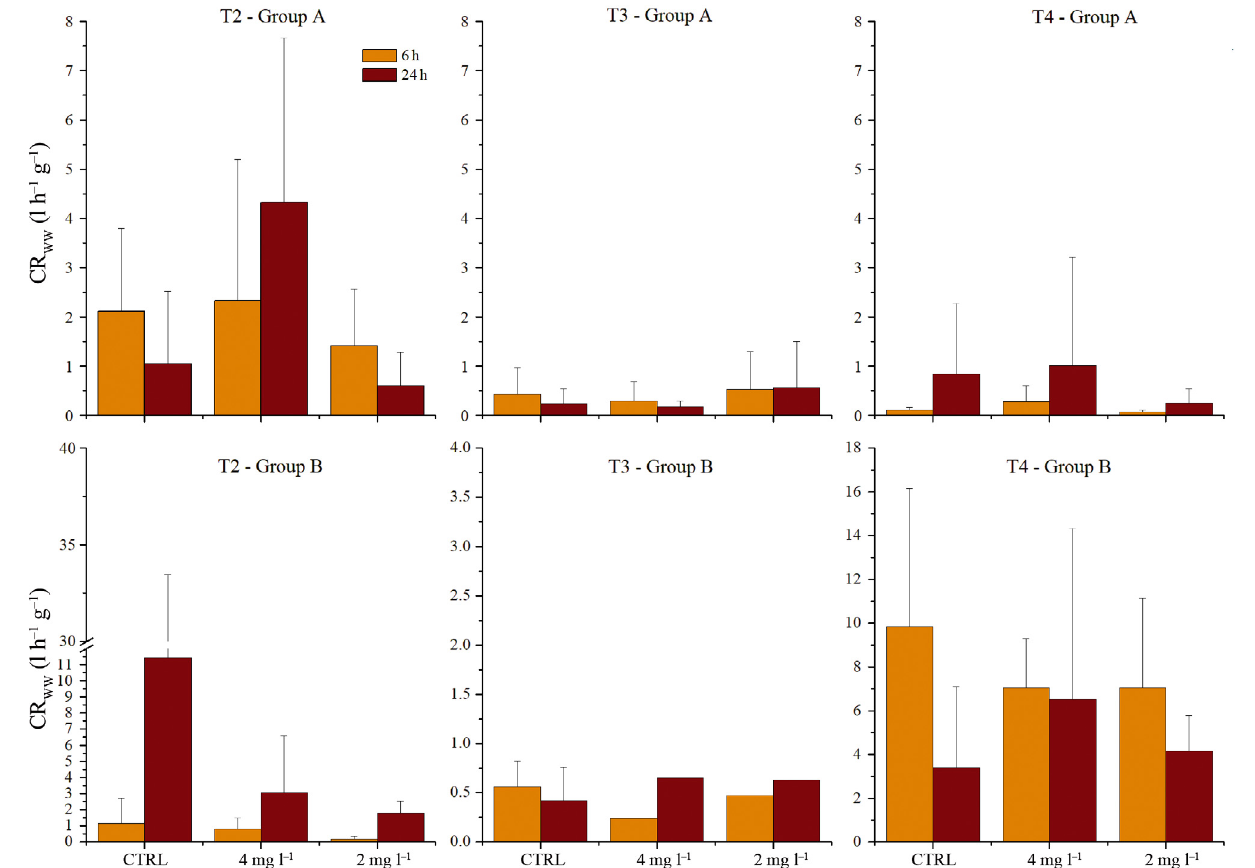
Fig. 1. Standardized clearance rates (CR) of biofouling communities at varying levels of oxygen availability after 6 and 24 h of treatment (CTRL [well-saturated], 4 mg l −1 and 2 mg l −1 ) for panels collected after 6, 9 and 12 mo submersion (Group A) (at T2, T3 and T4, respectively) and panels submersed for 3 mo and collected at T2, T3 and T4 (Group B). WW: wet weight. See Table 1 for